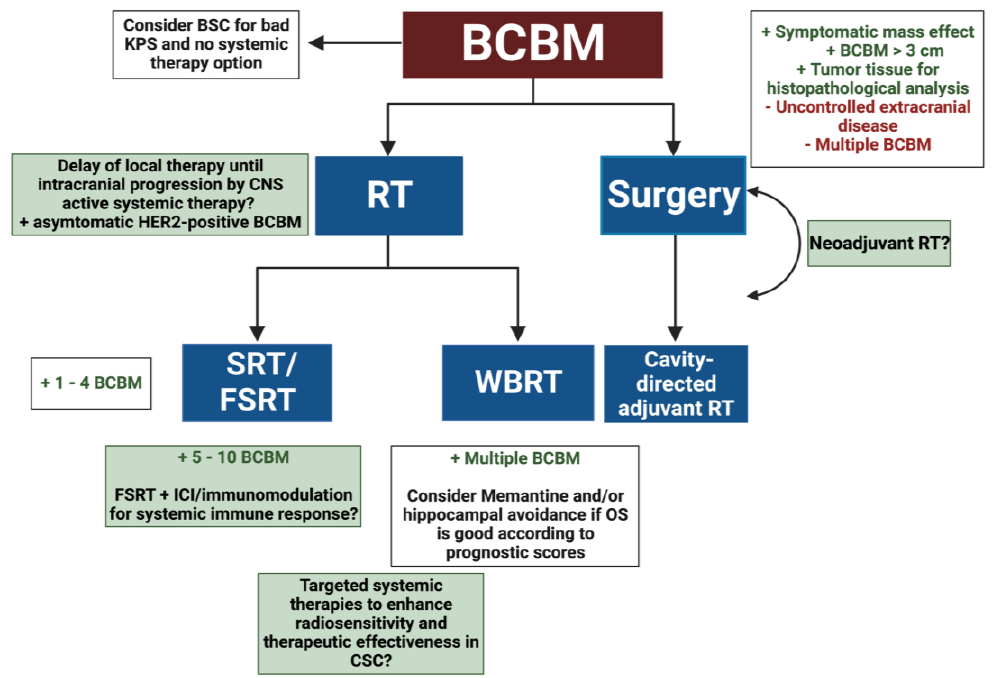
Figure 2. BCBM treatment flowchart adapted from the current ASCO-SNO-ASTRO guideline [68]. The flowchart provides an overview of current therapies (blue boxes) and future options (green boxes) for the treatment of brain metastases in breast cancer with favorable (green letters) and unfavorable outcomes (red letters). Abbreviations: Breast Cancer Brain Metastases (BCBM); Best Supportive Care (BSC); Karnofsky Performance Status (KPS); Whole Brain Radiation Therapy (WBRT); (Fractionated) Stereotactic Radiation Therapy (FSRT/SRT), Radiation Therapy (RT), Immune Checkpoint Inhibitor (ICI), Created with BioRender.com.